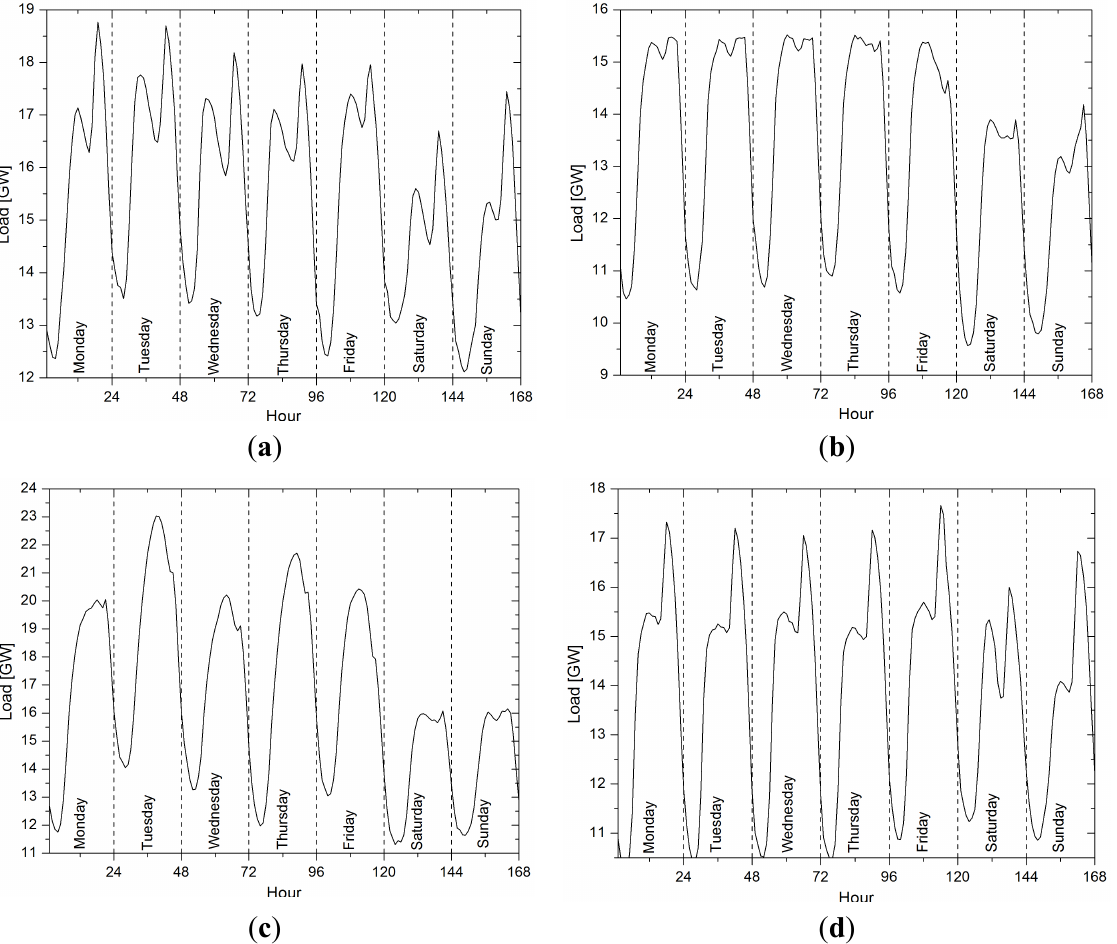
Figure 2. Hourly load during the week in ( a ) February 21–27; ( b ) May 16–22; ( c ) August 16–22; ( d ) November 15–21.